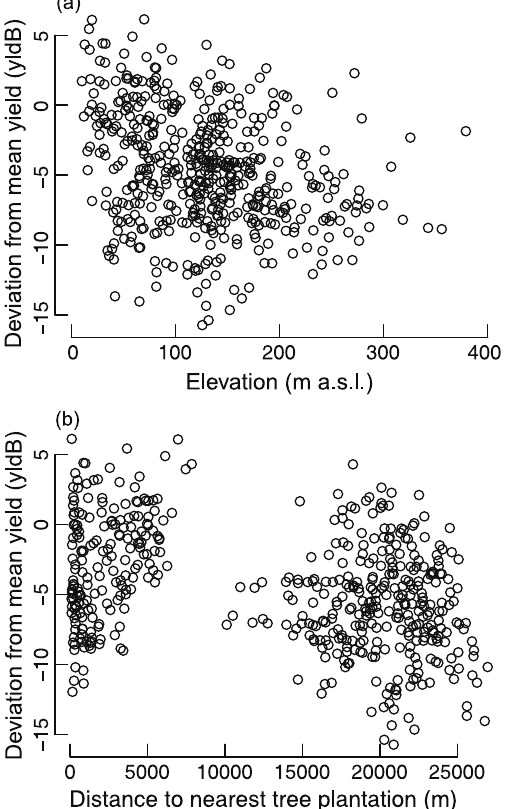
Figure 3. The relationship between oil palm yield and (a) elevation (m a.s.l.), and (b) distance to nearest non-native tree plantation. Oil palm yield was measured as the mean deviation from the yield-by-age curve generated from Butler et al. [47] (yldB), and is quantified as the fresh fruit bunch weight per hectare (mt ha 2 1 ).